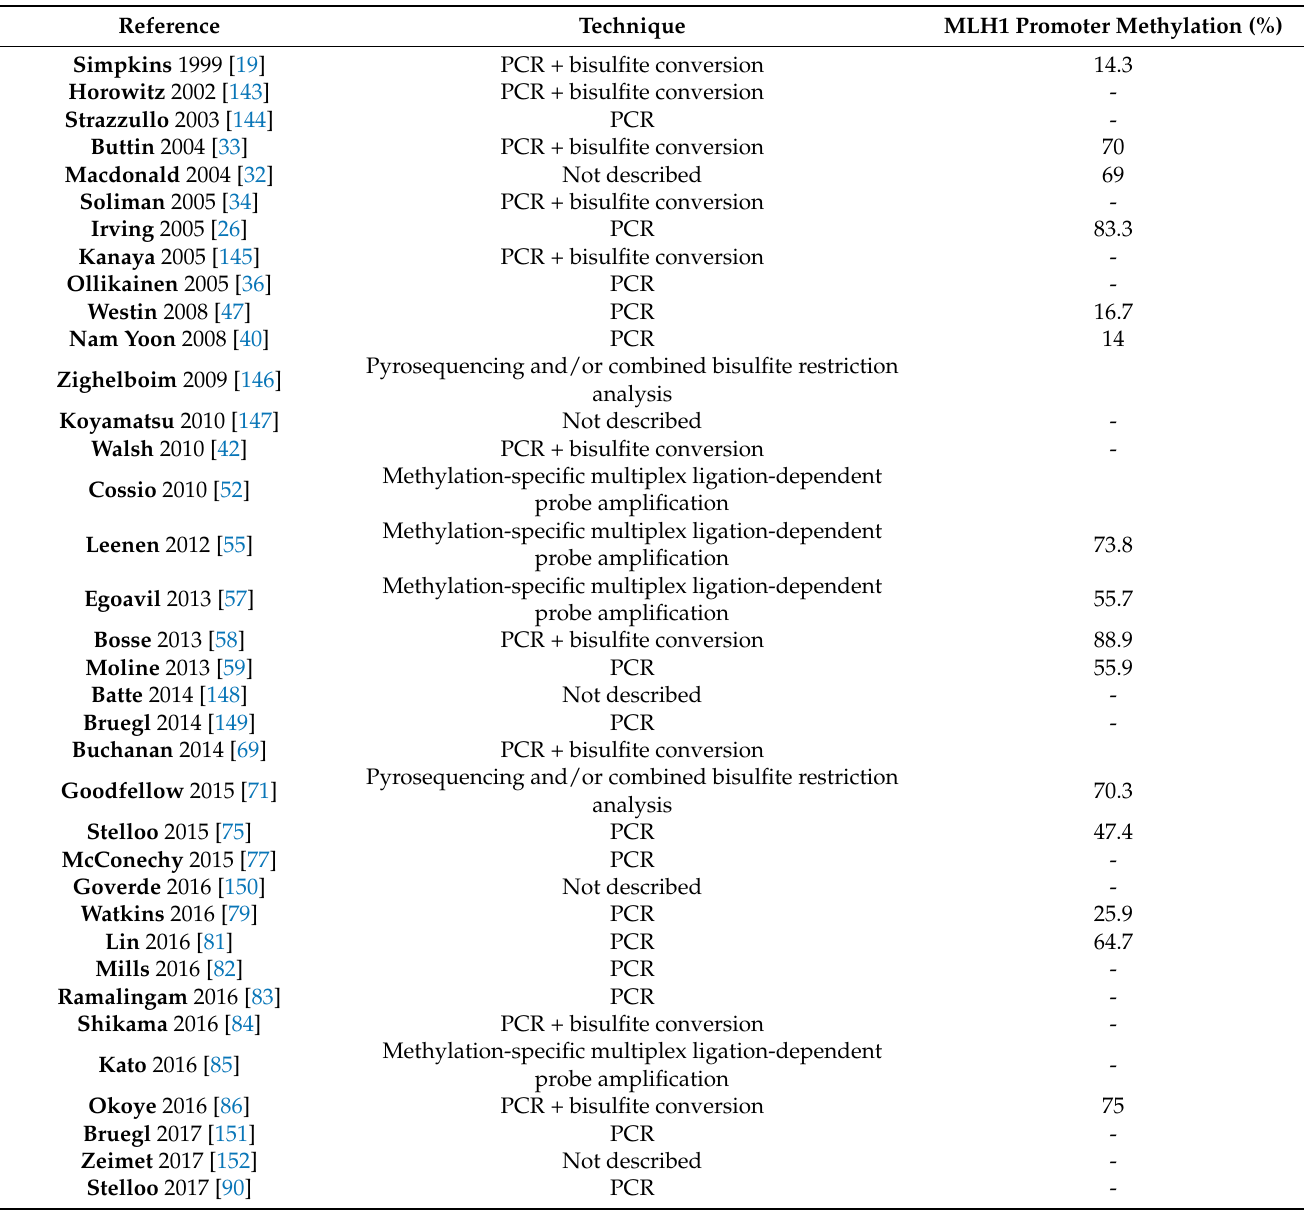
Table 4. Differences in MLH1 promoter